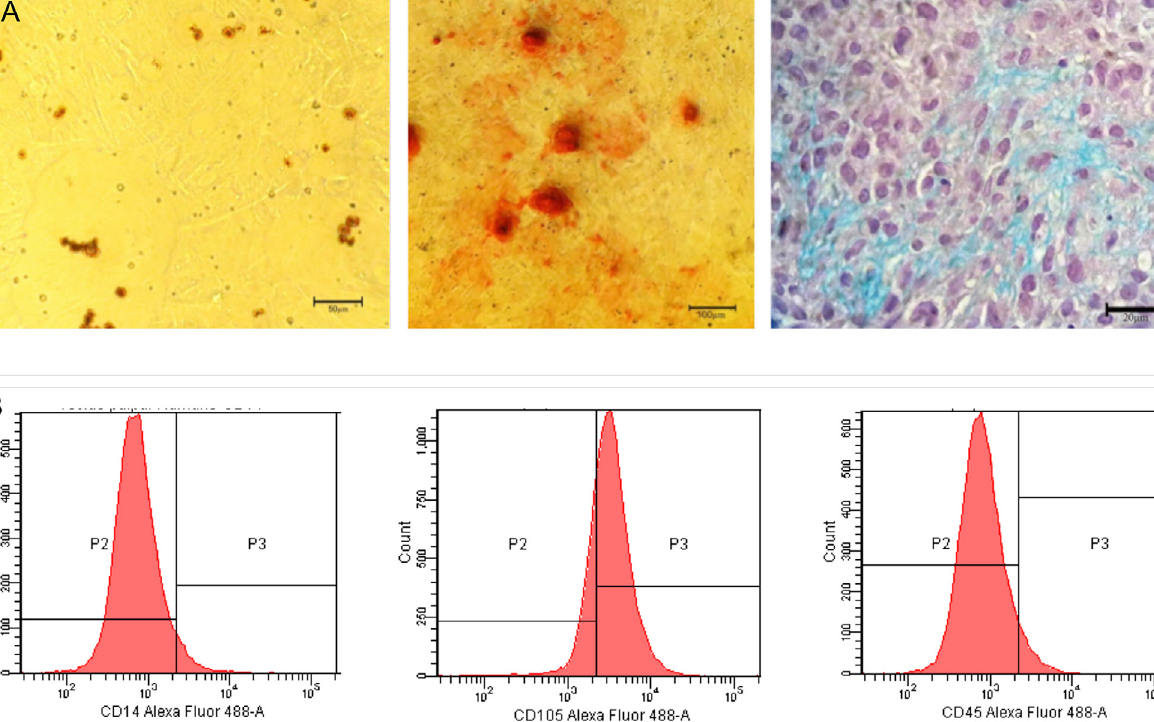
Figure 4- (A) From left to right, adipogenic differentiation stained with Oil Red showing lipid droplets, 50 μm bar, osteogenic differentiation stained with Alizarin Red showing calcium deposits and matrix, 100 μm bar, and chondrogenic differentiation stained with Alcian Blue showing glycosaminoglycans, 20 μm bar. (B) Cytometry flow of fibroblast cells originated from human permanent tooth pulp tissue, with expression of CD105 and non-expression of CD14 and